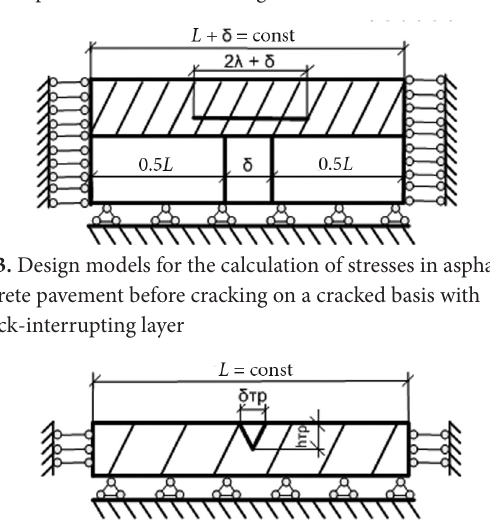
Fig. 4. Design model for the calculation of stresses in asphalt concrete pavement after crack appearance with thermal cracks in the upper zone of the asphalt pavement on a solid base